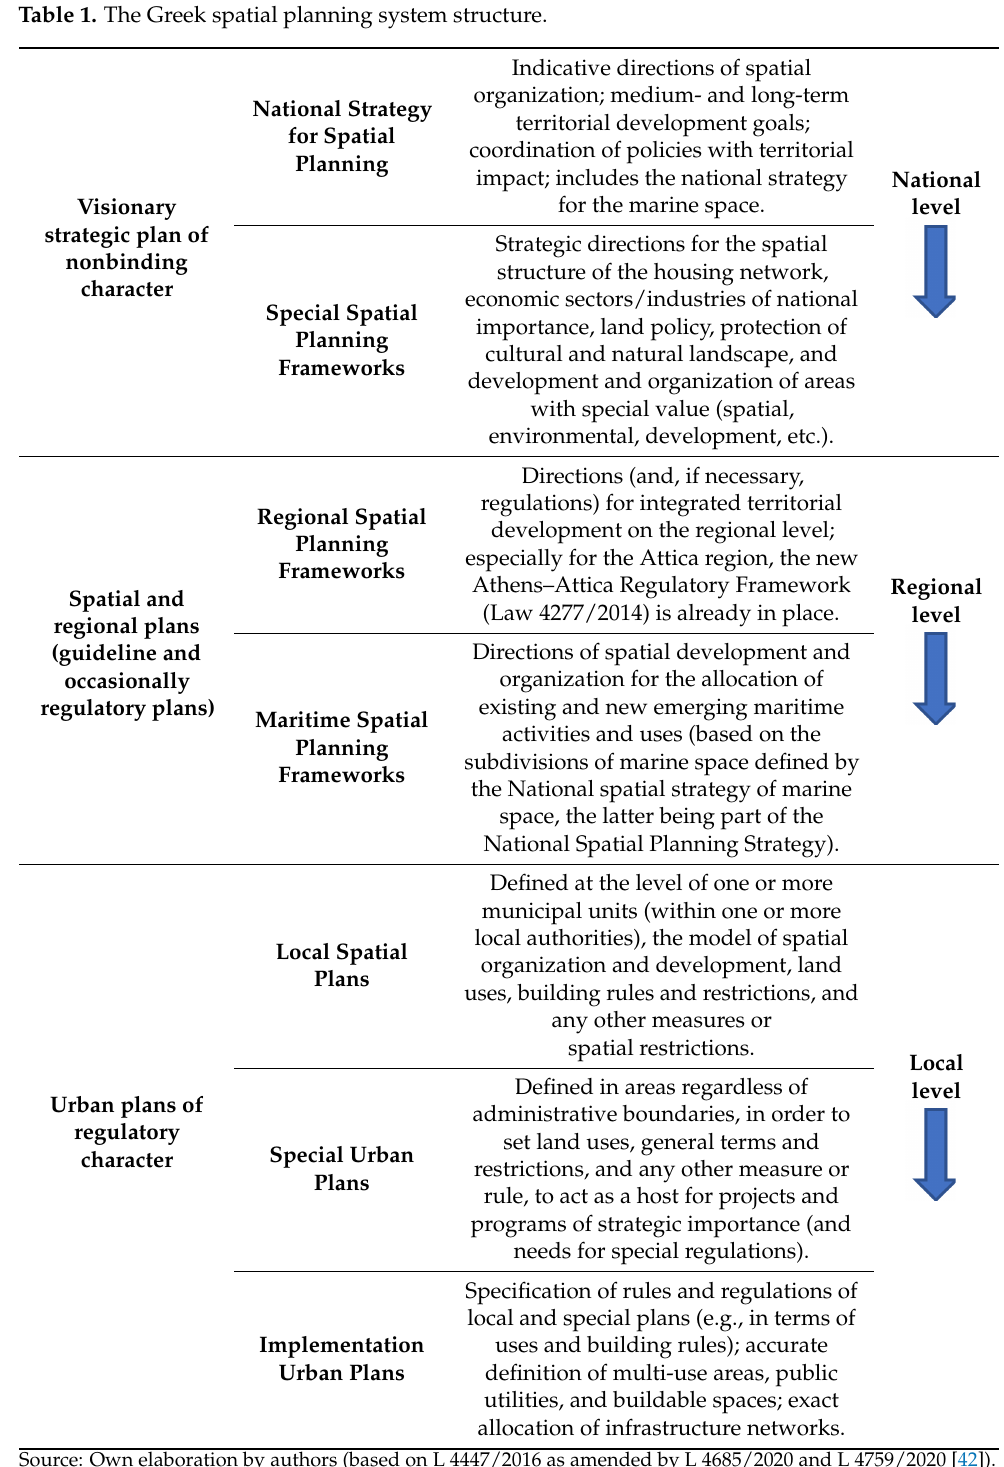
Table 1. The Greek spatial planning system